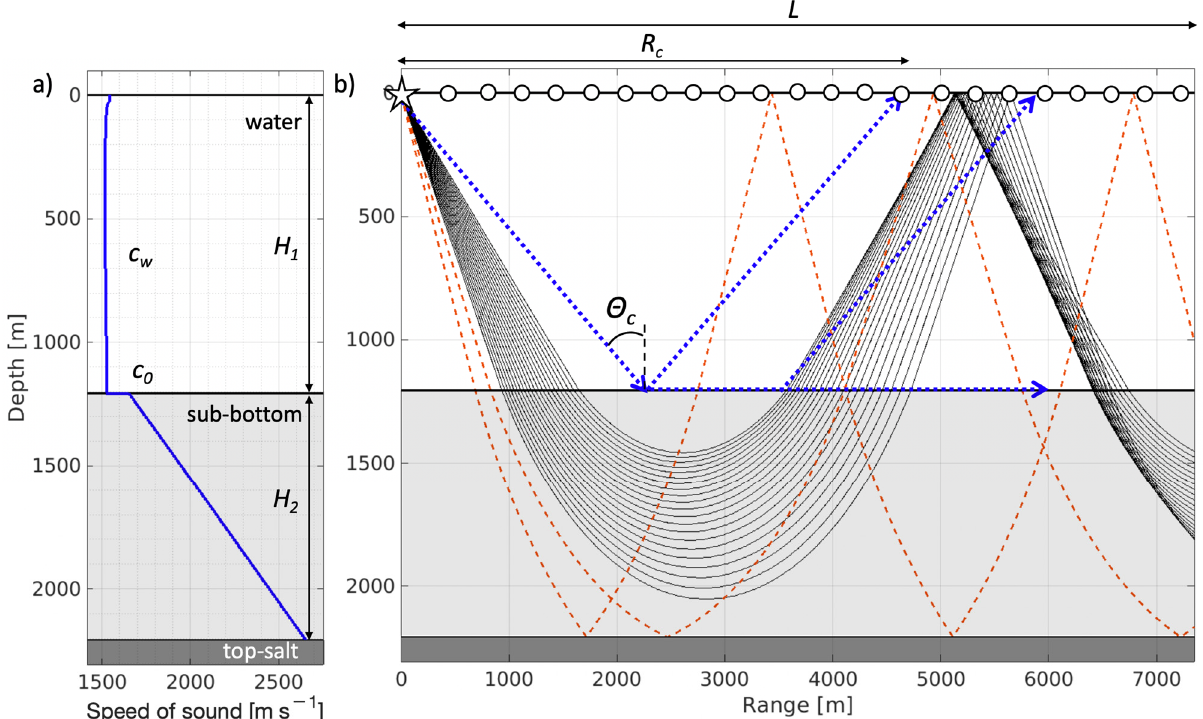
Figure 6. A schematic representation of rays propagating through our model with a linear velocity gradient in the sub- bottom layer down to the top salt, and a winter-oceanic-sound-velocity profile. ( a ) The sound-speed profile in the water and bottom that is used in the model. ( b ) A set of modeled rays (black curves), propagating through a multilayered medium that represents the velocity profile in ( a ). Blue dotted arrows schematically represent, for a comparison, the outline of a head wave propagating through a constant-velocity water model at the critical angle of incidence θ c and the critical distance R c . L is the length of the horizontal line array of hydrophones. Red dashed curves represent rays reflected from the top-salt interface.